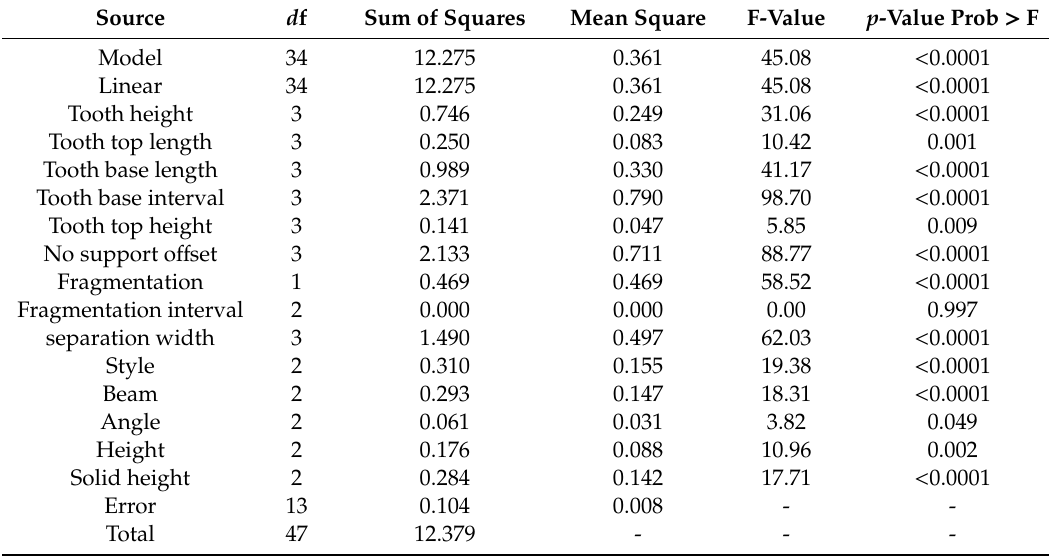
Table 3. ANOVA for support removability with respect to the support design parameter (hatching